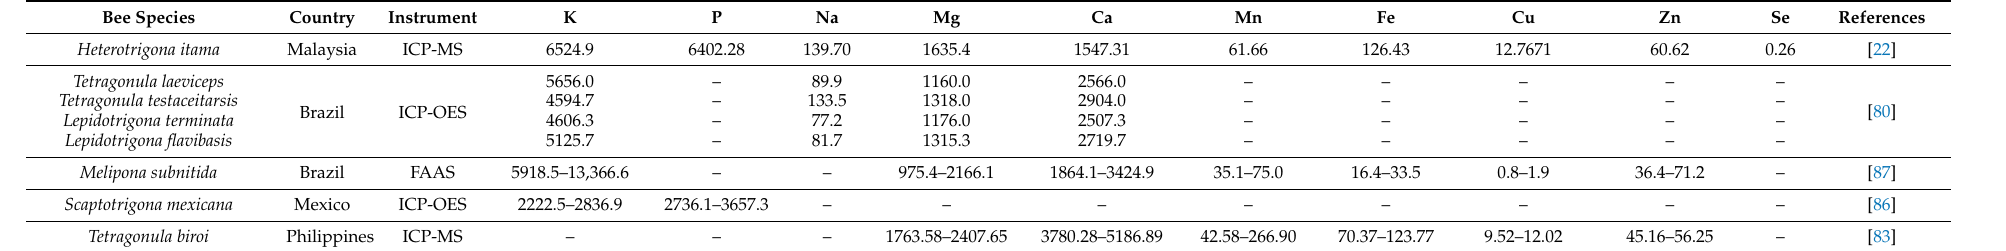
Table 5. Mineral composition in stingless bee bee